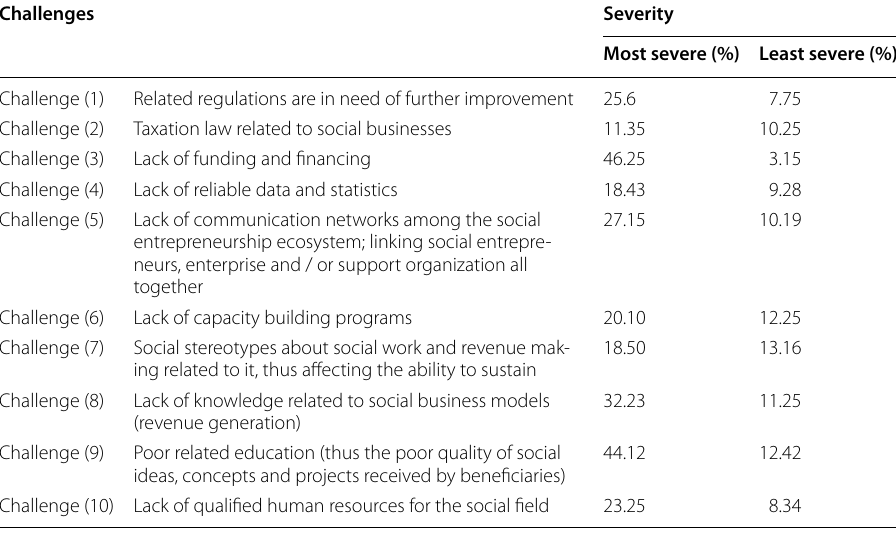
Table 8 Ranking of the challenges based on severity